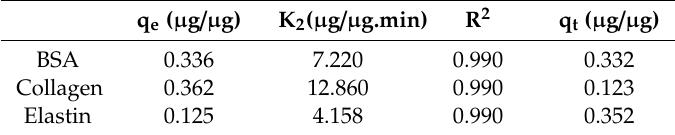
Table 3. Parameters calculated from the pseudo-second-order kinetic model.